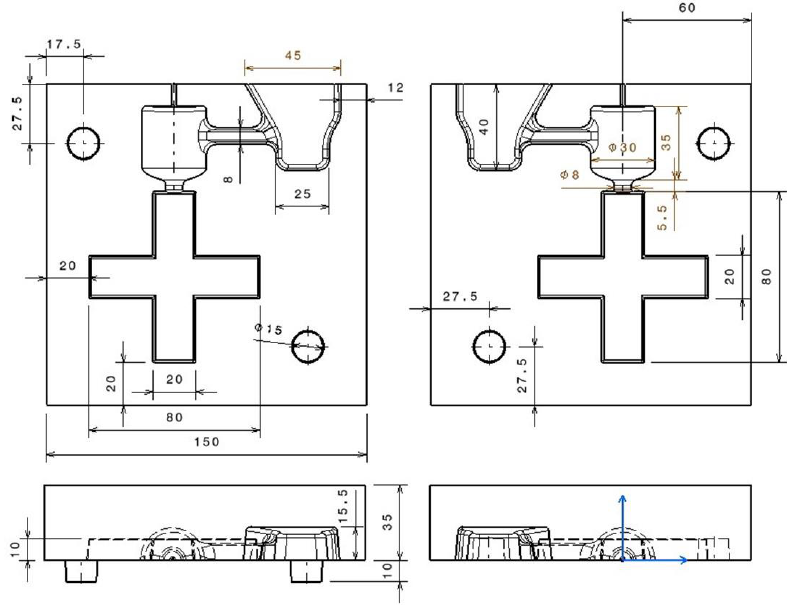
Figure 1. Cross shaped casting layout (dimensions in mm).